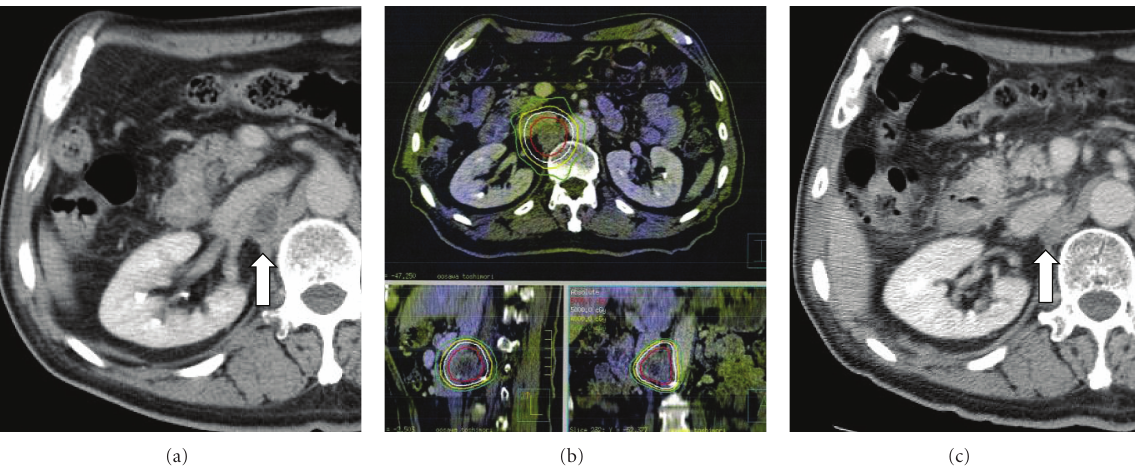
Figure 2: (a) CT of right para-aortic lymph node metastasis (arrow) before SBRT. (b) Dose distribution made with 10 noncoplanar beams for SBRT. Isodose lines show total doses (in 20 fractions) of 60 Gy, 50Gy, 40 Gy, and 30 Gy, respectively, from the innermost area. (c) CT at 4 months after SBRT, showing partial response of the lesion